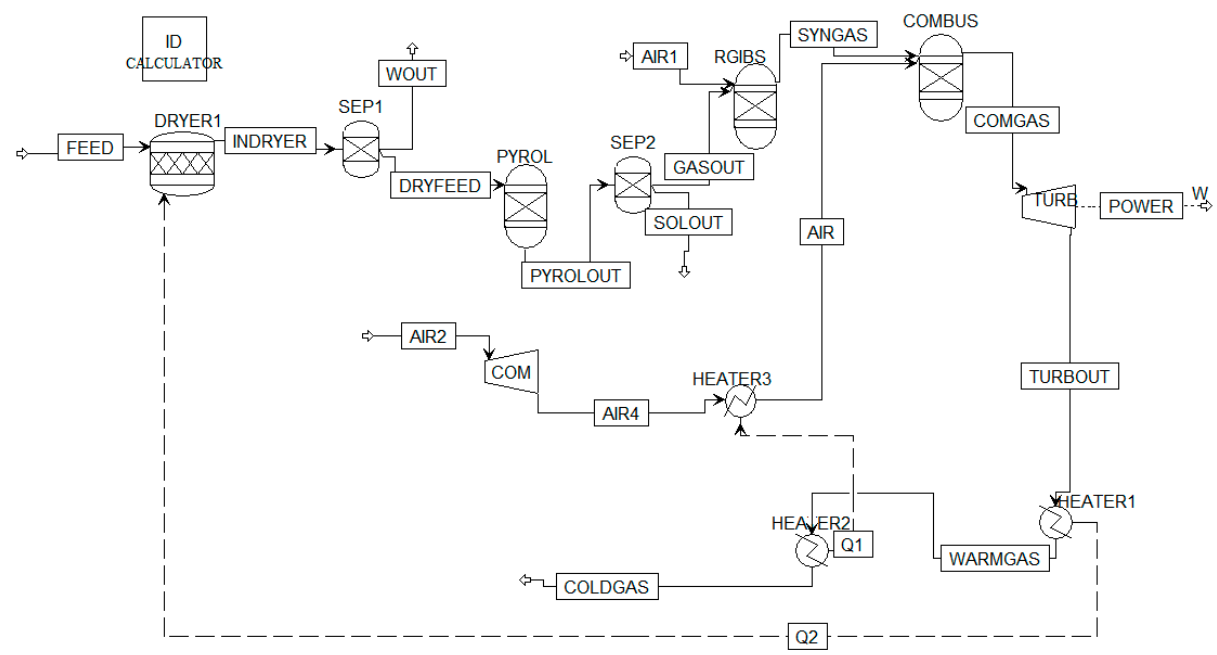
Figure 2. Diagram of gasification simulation in Aspen Plus. Table 2. Ultimate and proximate analysis of 28 WB&FR [44–61], (M: moisture content, VM: volatile materials, FC: fixed carbon, A: ash, C: carbon, O: oxygen, H: hydrogen, N: nitrogen and S: sulfur).